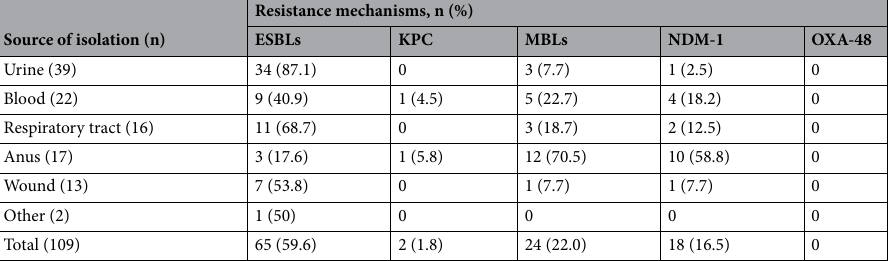
Table 1. The prevalence of resistance mechanisms in K. pneumoniae isolated from different clinical materials. ESBLs—extended spectrum beta-lactamases, KPC—carbapenemase class A, MBLs—metallo-β-lactamases, NDM-1—New Dehli metallo-β-lactamase, OXA-48—carbapenemase class D.